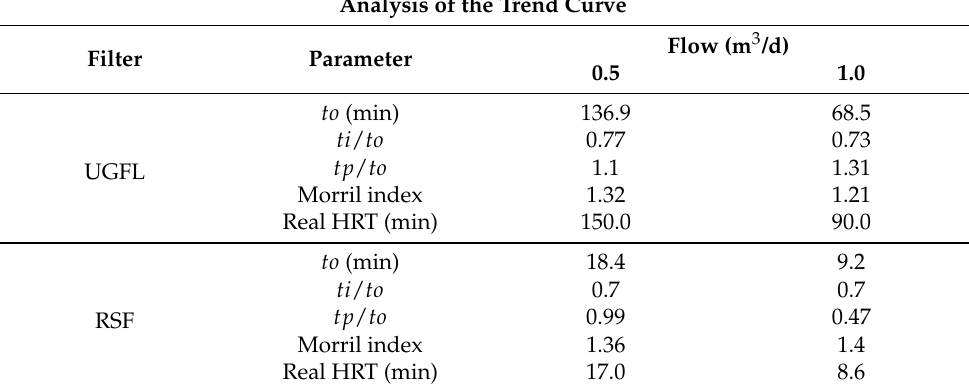
Table 5. Results of the trend curve analysis.